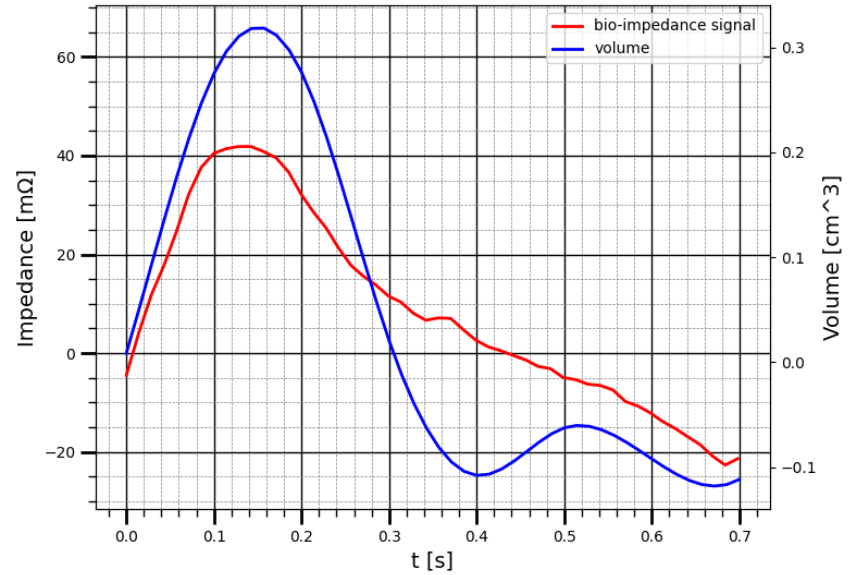
Figure 11. The correlation between bio-impedance signal and the blood volume change of kidney using ultrasound. using